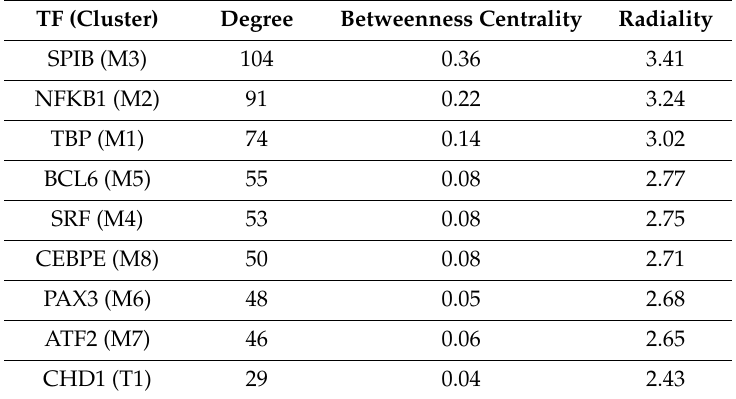
Table 2. Summary of topological indexes used to evaluate the centrality of each candidate TF in the reconstructed gene regulatory